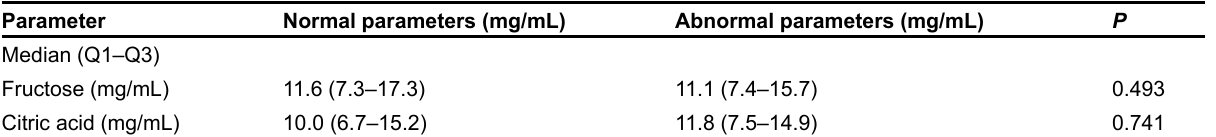
No significant difference was observed in the seminal fructose and citric acid levels amongst men with normal and abnormal sperm parameters as median seminal fructose and citric acid levels were